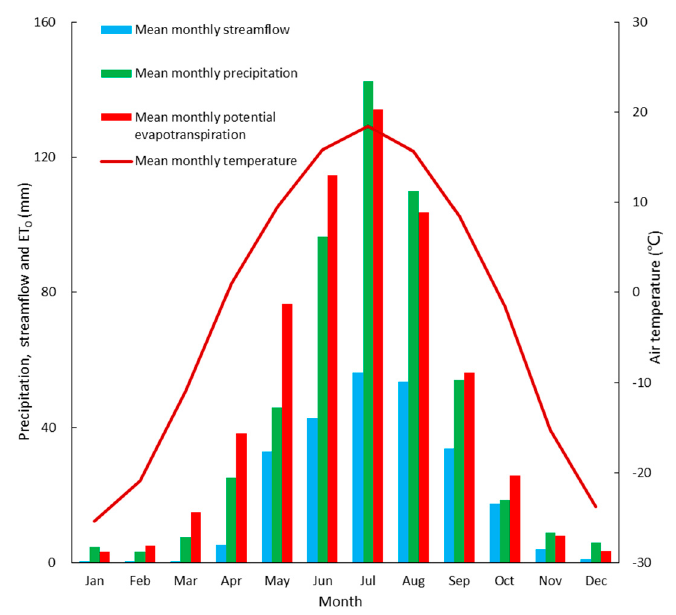
Figure 2. Mean monthly streamflow, precipitation, potential evapotranspiration (ET 0 ) and air temperature in the Tahe watershed from 1972 to 2016.